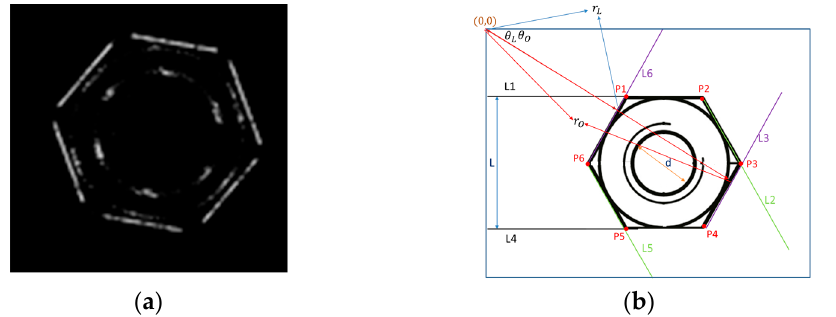
Figure 5. Determining the angle of each edge: (a) Displaying only the directions of the six edges; (b) Method of determining the angle of opposite edges.